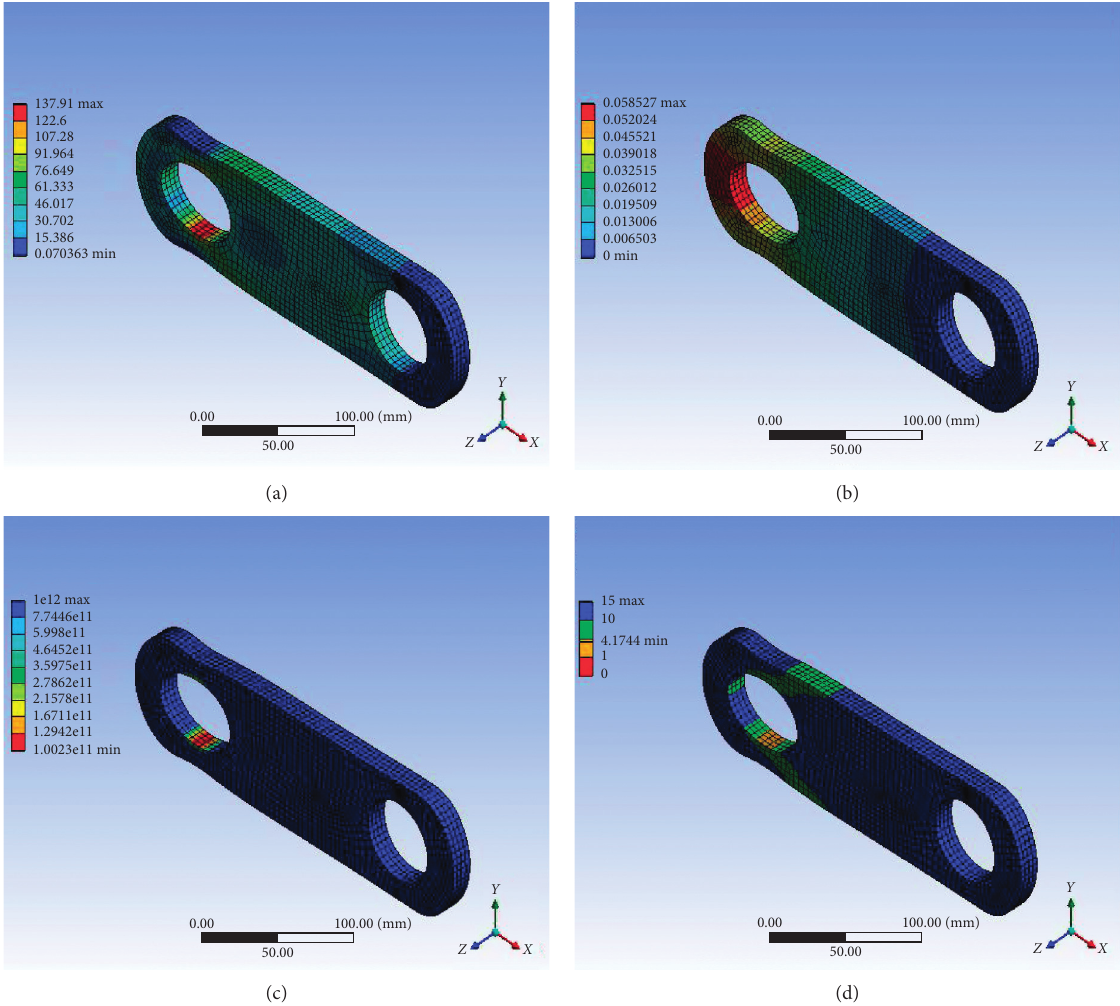
Figure 13: Simulation results for chain link with a modeled crack and neck radius 0mm ( X � 0mm): (a) equivalent stress, (b) deformation, (c) fatigue life, and (d) safety